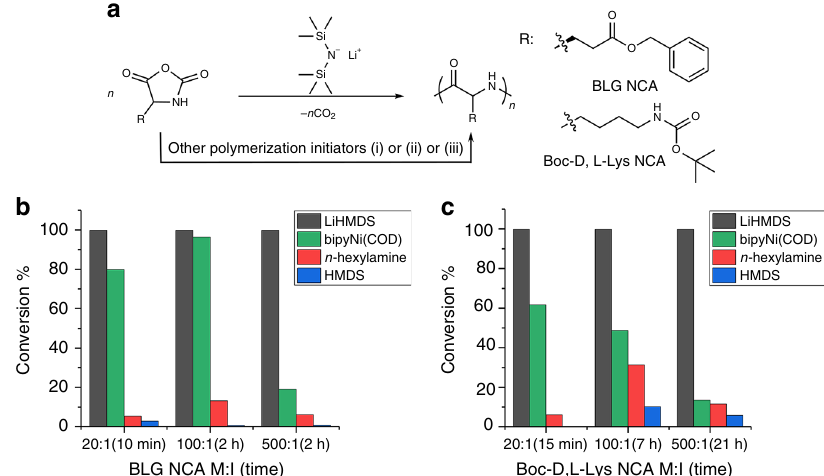
Fig. 1 Ring-opening polymerization of NCA initiated by LiHMDS and other initiators. a NCA polymerization initiated by LiHMDS or other initiators in THF, initiator (i) n-hexylamine, initiator (ii) HMDS, initiator (iii) bipyNi(COD); b conversion of BLG NCA in LiHMDS, n-hexylamine, HMDS or bipyNi(COD) initiated polymerization at variable NCA:initiator ratios using THF as the reaction solvent; c conversion of Boc-D,L-Lys NCA in LiHMDS, n-hexylamine, HMDS, or bipyNi(COD) initiated polymerization at variable NCA:initiator ratios using THF as the reaction